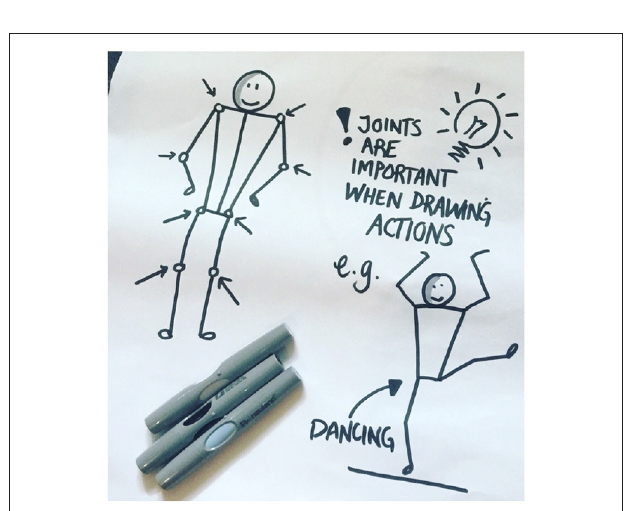
FIGURE 5 | Pre-COVID-19 teaching sketching in UX design: demonstrating figure design using sharpie markers on paper. Makayla Lewis, 2018.